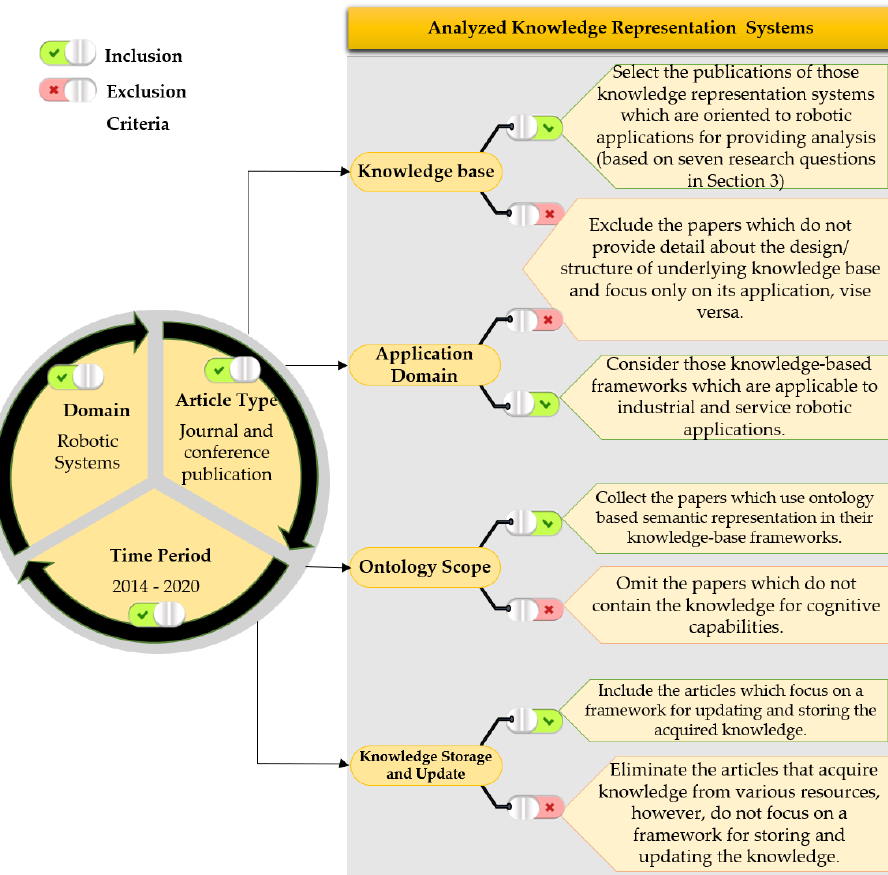
Figure 2. Inclusion and exclusion criteria for KR systems reviewed in our survey (Section